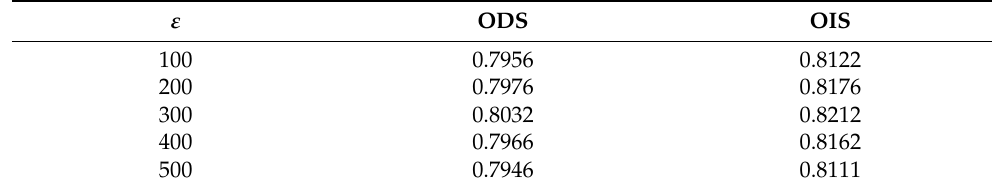
Figure 7. Comparison of annotation styles of the BSDS500 and the NYUDv2. The first two columns are origin images and ground truths of the BSDS500, respectively. The last two columns are origin images and ground truths of the NYUDv2, respectively. Table 6. Effect of balance factor on the edge detection performance on the BSDS500.